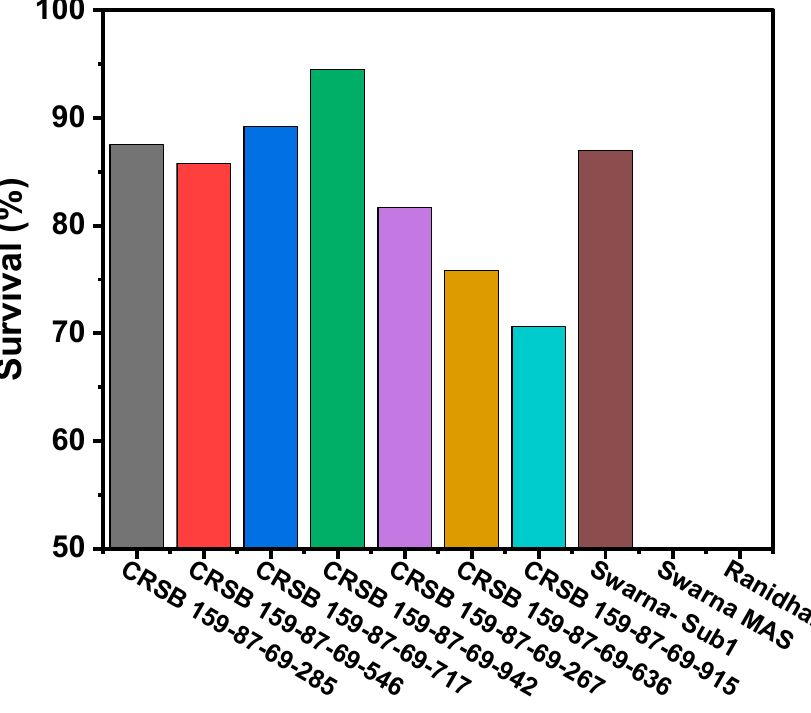
Figure 7. Regenerated plants (%) carrying the Sub1 QTL in the pyramided and parental lines evaluated under the control screening conditions 1 week after 14 days of submergence stress. Table 2. Mean percentage survival of pyramided and parental lines submerged for 14 days, and then de-submerged and regenerated after 7 days in the BC 3 F 4 and BC 3 F 5 generations. Sl.